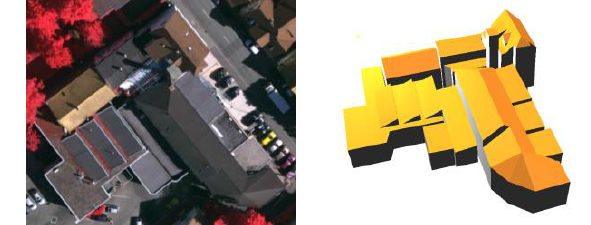
Fig. 8 Segmentation results of buidlings with complex